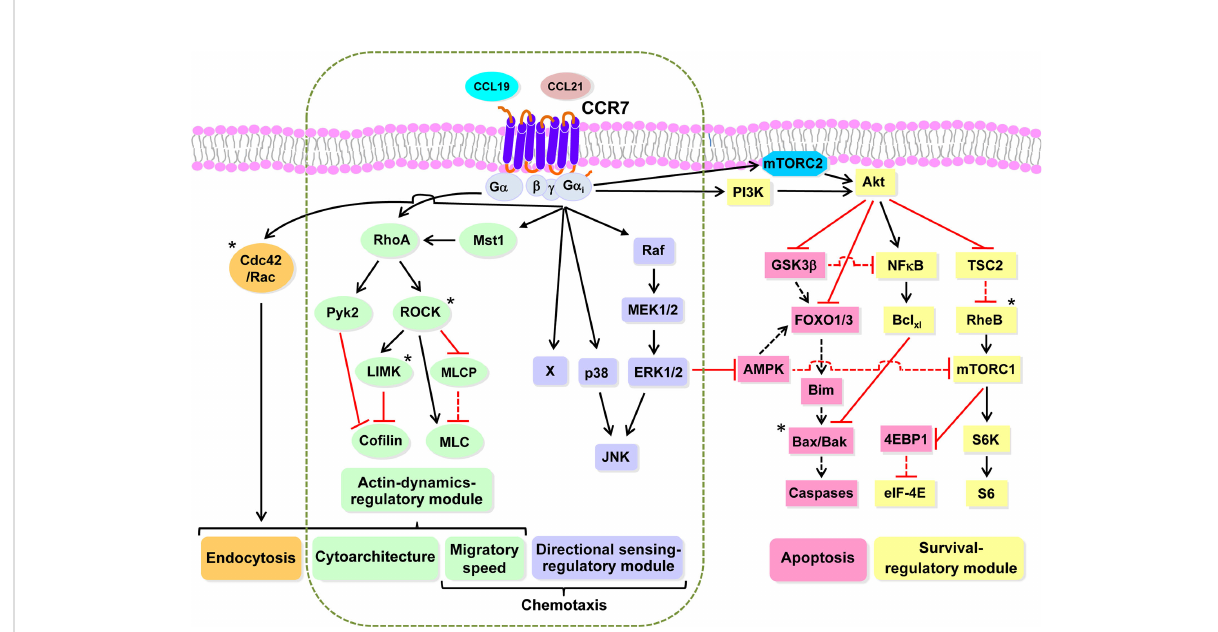
FIGURE 3 CCR7 uses highly independent signaling modules to regulate the functions of dendritic cells Working model based largely on our experimental data obtained studying the functions and signaling molecules controlling the functions of CCR7 in DCs. Black and red lines indicate stimulatory and inhibitory effects, respectively. A dashed black or red line indicates that after stimulation of CCR7, ceases the indicated effect, either activation or inhibition, exerted by the indicated molecule. An asterisk indicates molecules not analyzed experimentally by us, which are included based on bibliographic information. Endocytosis can be downstream of RhoA (green) and Rac/Cdc42 (orange). The dashed vertical rounded rectangle includes the signaling modules governing CCR7-induced actin dynamics and directional sensing. Signaling module governing CCR7-mediated directional sensing (mallow). Signalling module controlling CCR7-mediated actin dynamics (green). Signaling module controlling CCR7-mediated survival (yellow). Pro-apoptotic molecules that are inhibited by the survival regulatory module ( fl esh colour). Abbreviations used (see also legend to Figure 1, for additional abbreviations): Akt, AK strain mouse Thymoma; AMPK; 5 ’ AMP-activated protein kinase; Bak, Bcl-2-antagonist/killer; Bax, Bcl-2-Associated X Protein; Bclxl, B-cell lymphoma-extra-large; Bim, Bcl-2 Interacting Mediator of